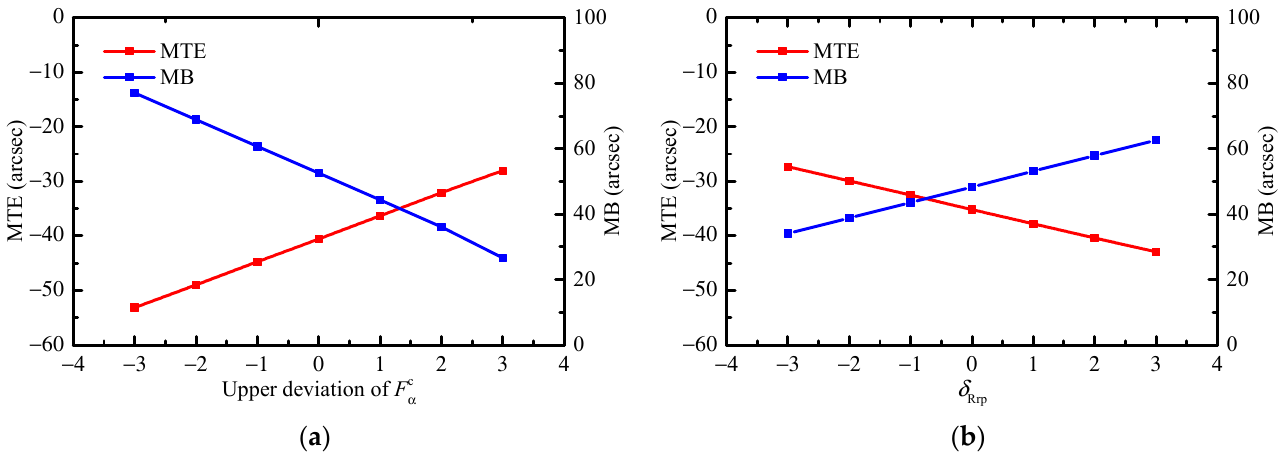
Figure 10. Results with MEs: ( a ) TE and ( b ) backlash.